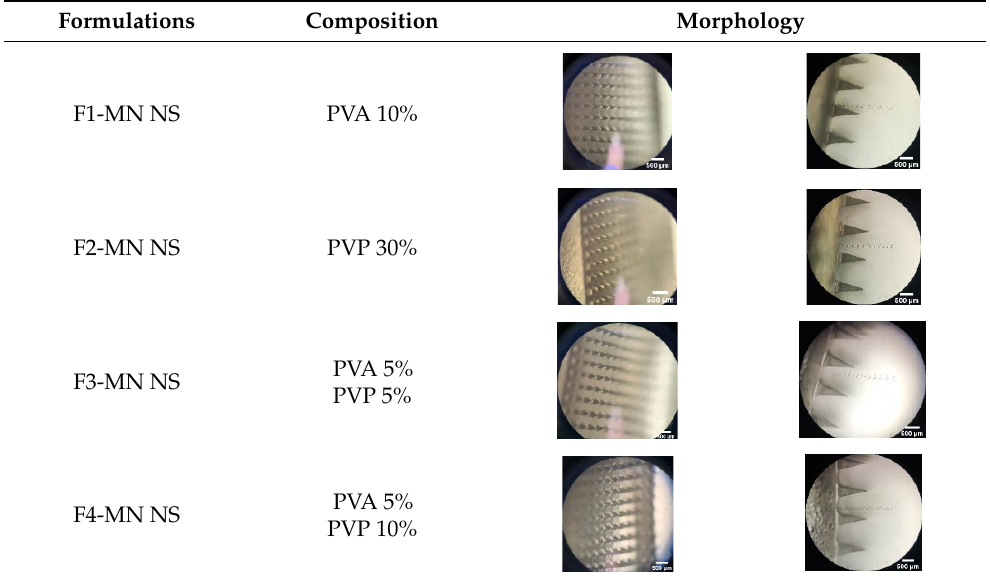
Table 4. Observation Results of Dissolving Microneedle Loaded with Ketoprofen Nanosuspension Through a Microscope (scale bar: 500 µm).